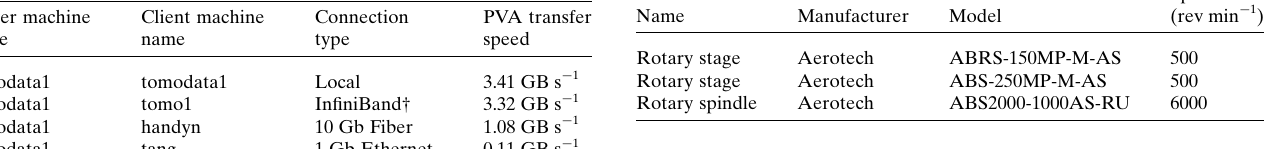
Table 2 Data transfer speed over the network using the pvAccess (PVA) channel for different connection types.